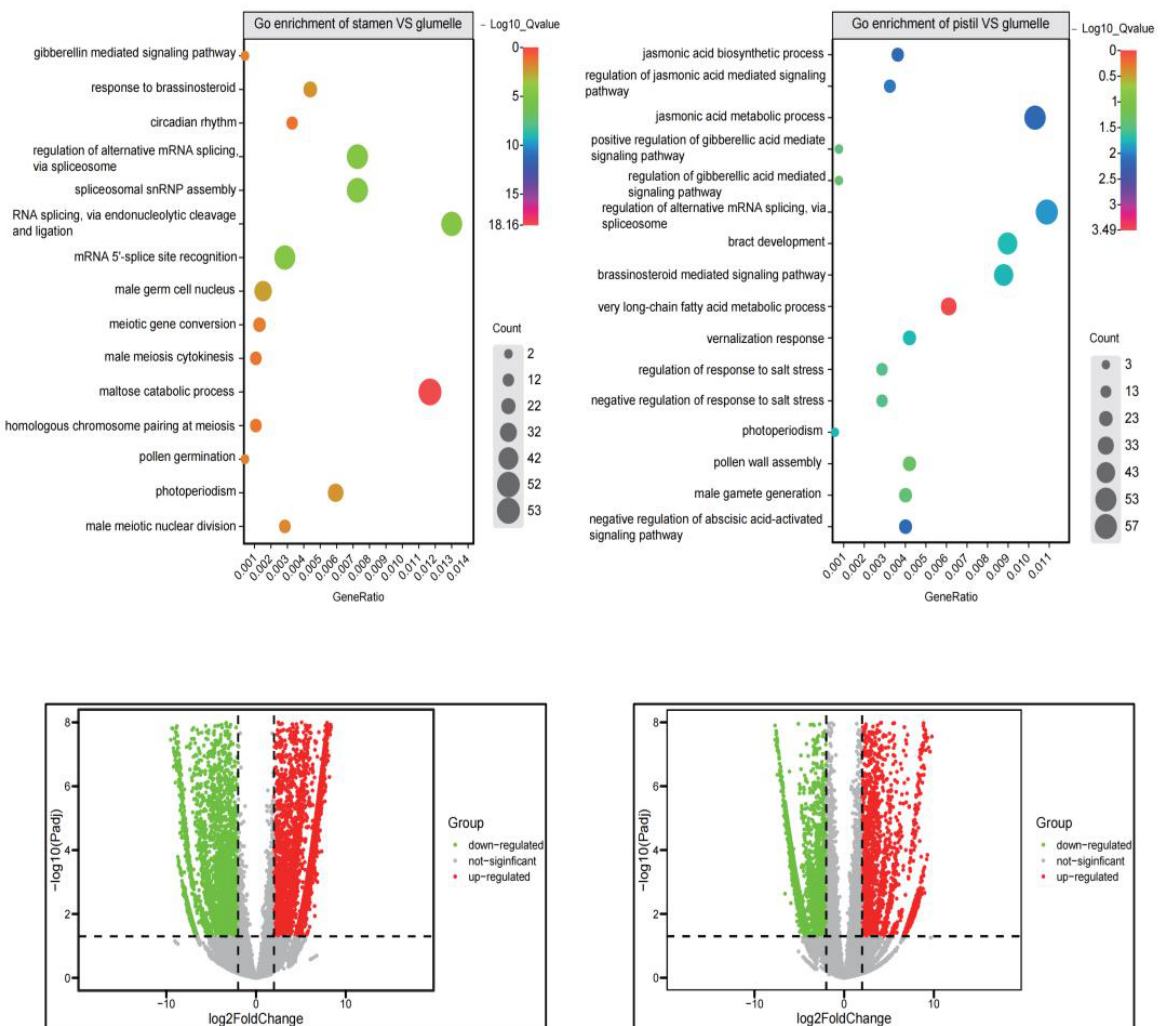
Figure 4. Gene ontology enrichment analysis of DEGs in flower organs.